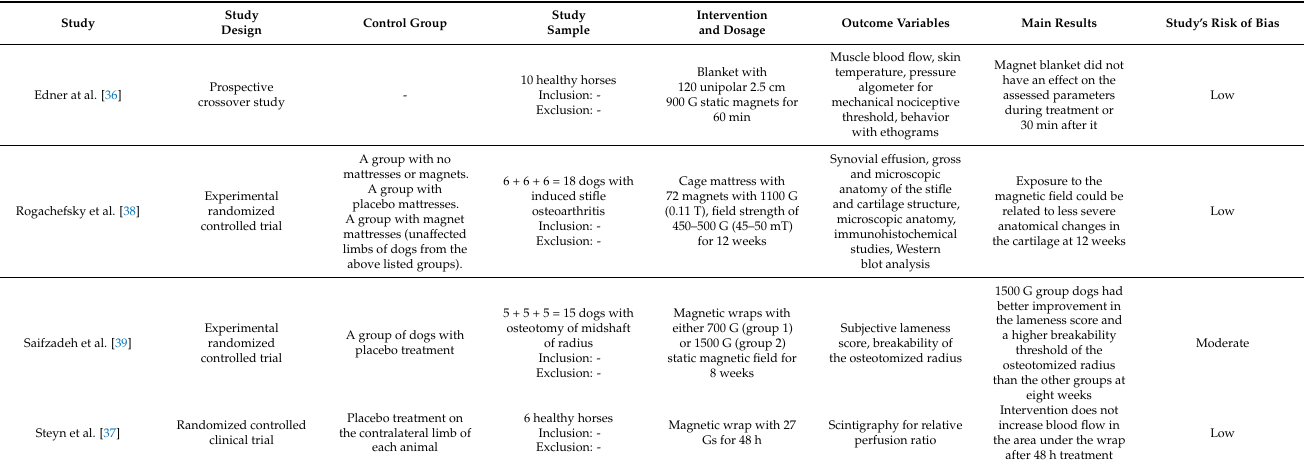
Table 5. Review of articles regarding static